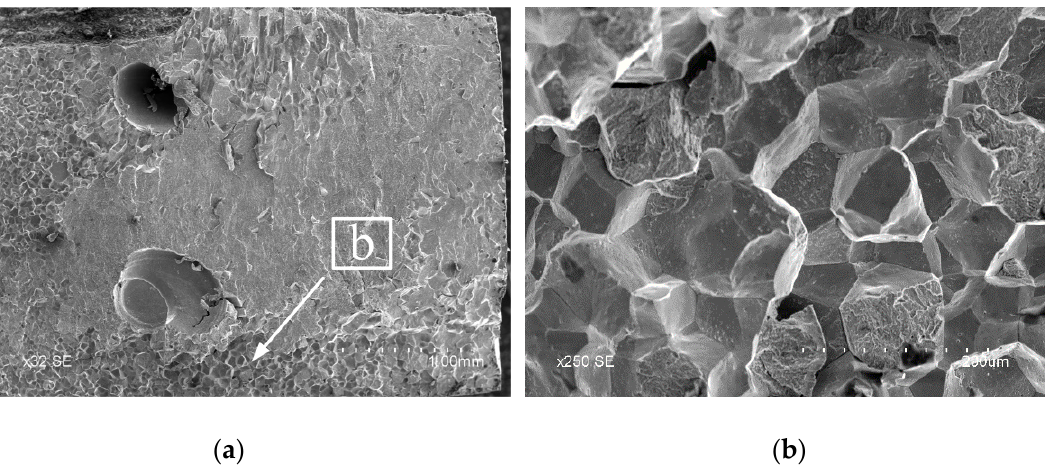
Figure 10. The fracture of the weld without preheating in plane fracture toughness test: ( a ) The overall morphology; ( b ) the enlargement of b.